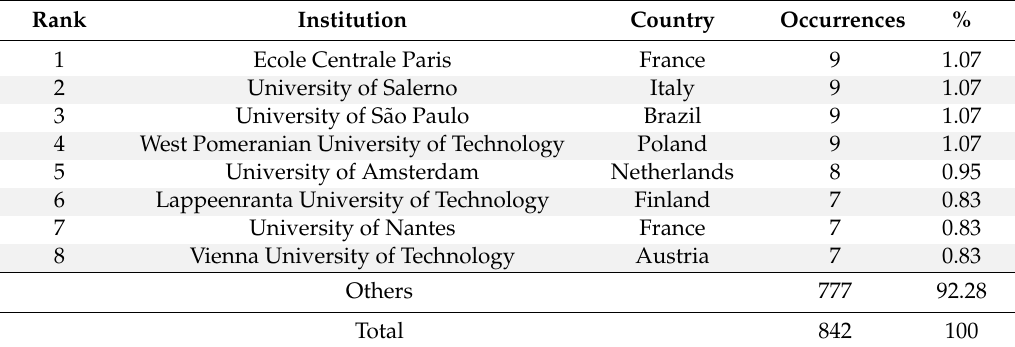
Table 8. Occurrences of most productive institutions in competence-based